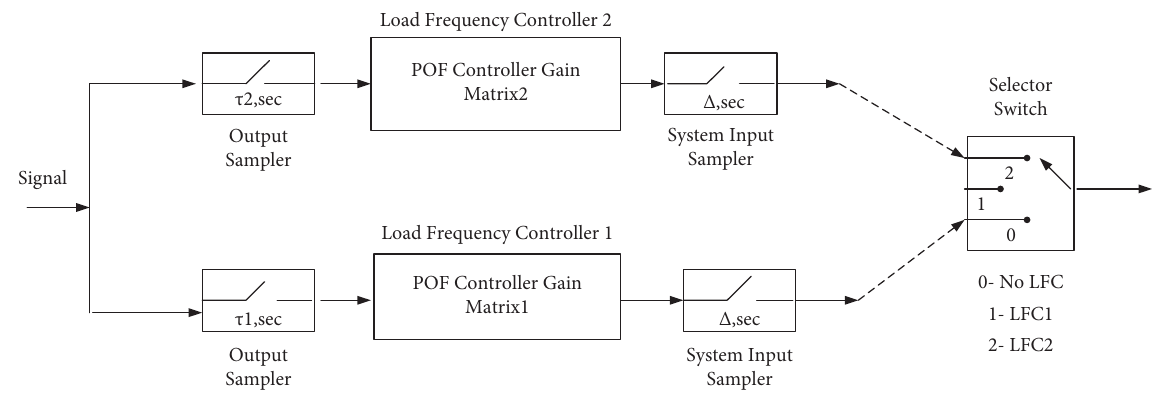
Figure 8: Te scheme for accidental change in the sampling